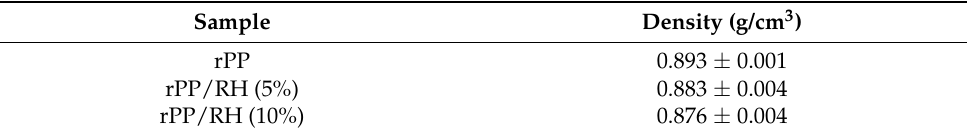
Table 1. Density of neat rPP and rPP/RH